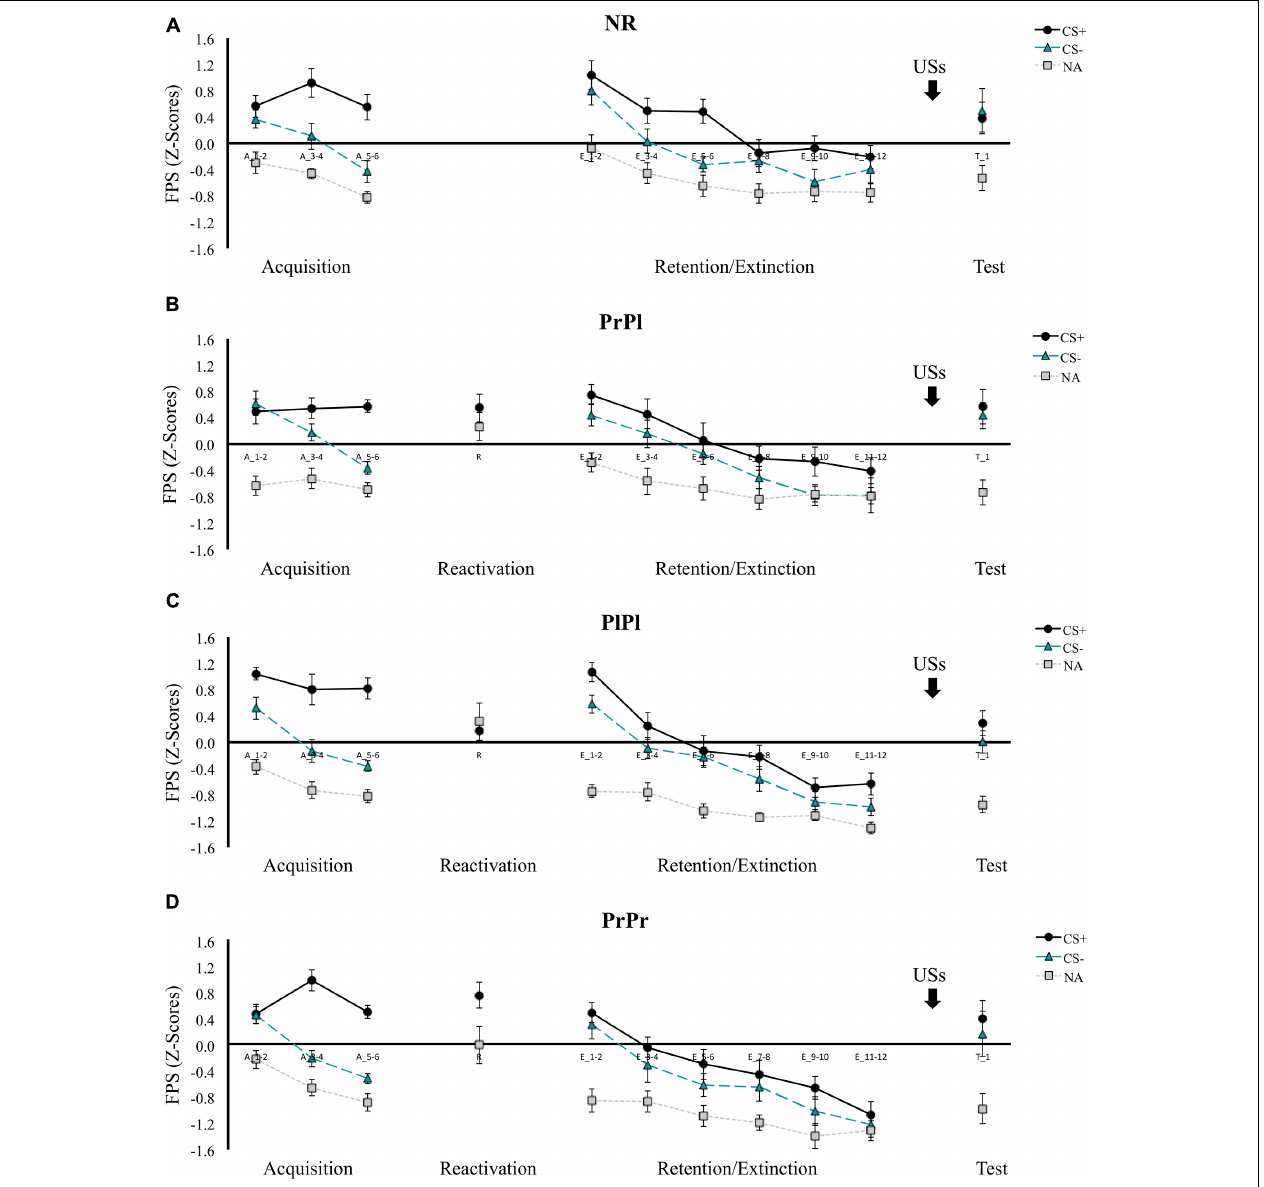
FIGURE 3 | Mean FPS scores ( Z -transformed) across all phases for (A) the NR group, (B) the PrPl group, (C) the PlPl group, and (D) the PrPr group. Error bars represent standard error of the